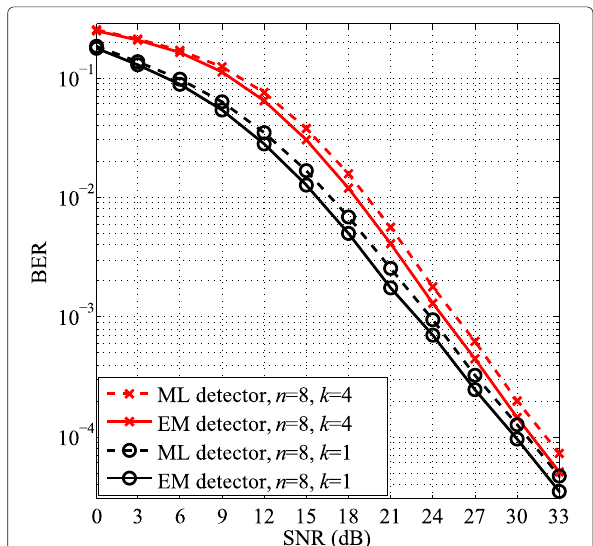
Fig. 3 Comparison of BER performance for DM-OFDM-IM ( n = 8, BPSK). Figure 3 shows the comparison results of ML and EM detectors in terms of BER for